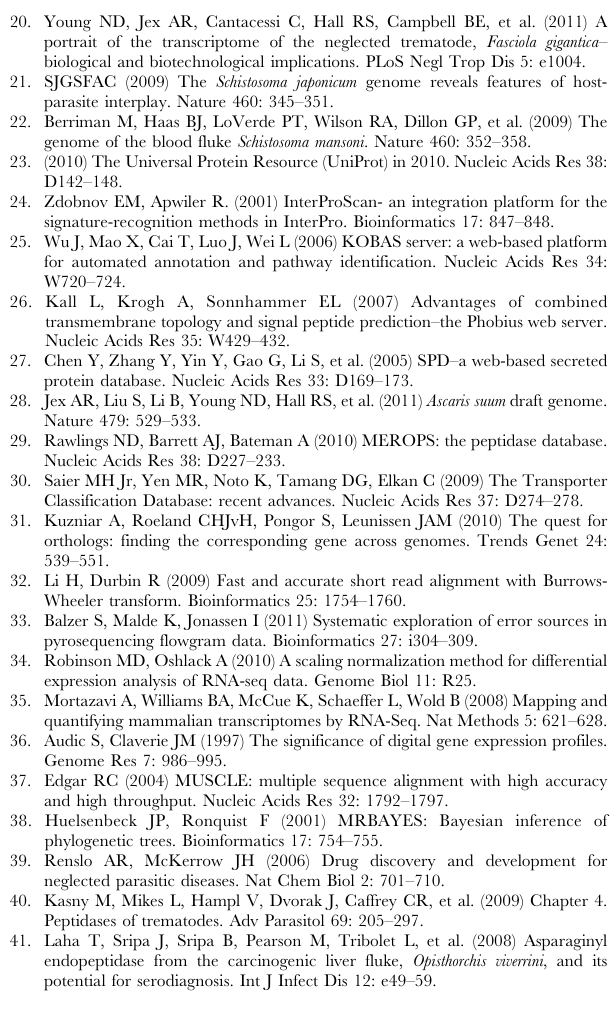
Table S4 Comparative summary of the enriched tran- scription of conserved biological pathways in adult or juveniles of Opistorchis viverrini based on orthology to molecules in the Kyoto Encyclopaedia of Genes and Genomes (KEGG). Table S5 Comparative summary of the functional classes of adult or juvenile-enriched transcripts of Opistorchis viverrini based on the classification of their encoded protein domains in the Gene Ontology (GO) based classification system ( http://www.geneontology.org/ ). Table S6 Comparative summary of the functional classes of adult or juvenile-enriched transcripts of Opistorchis viverrini based on the presence of conserved protein domains annotated in the PFAM database ( http://pfam.sanger.ac.uk/ ).